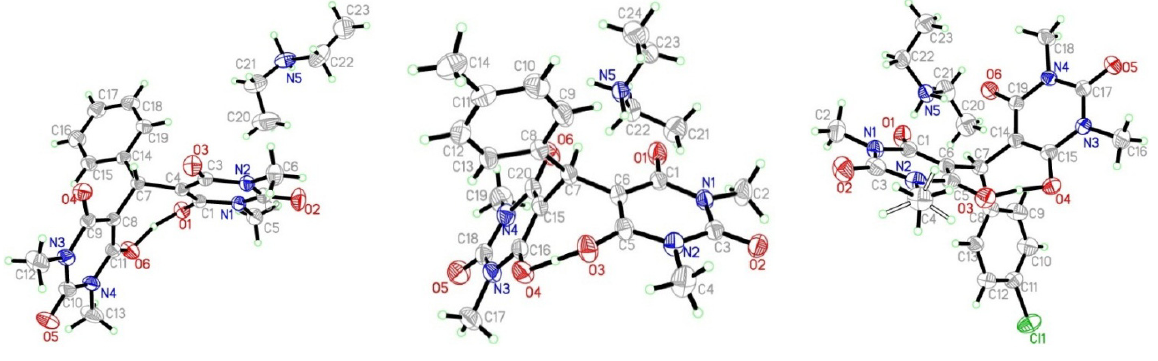
Figure 2. ORTEP representation of the structure of 3a – c